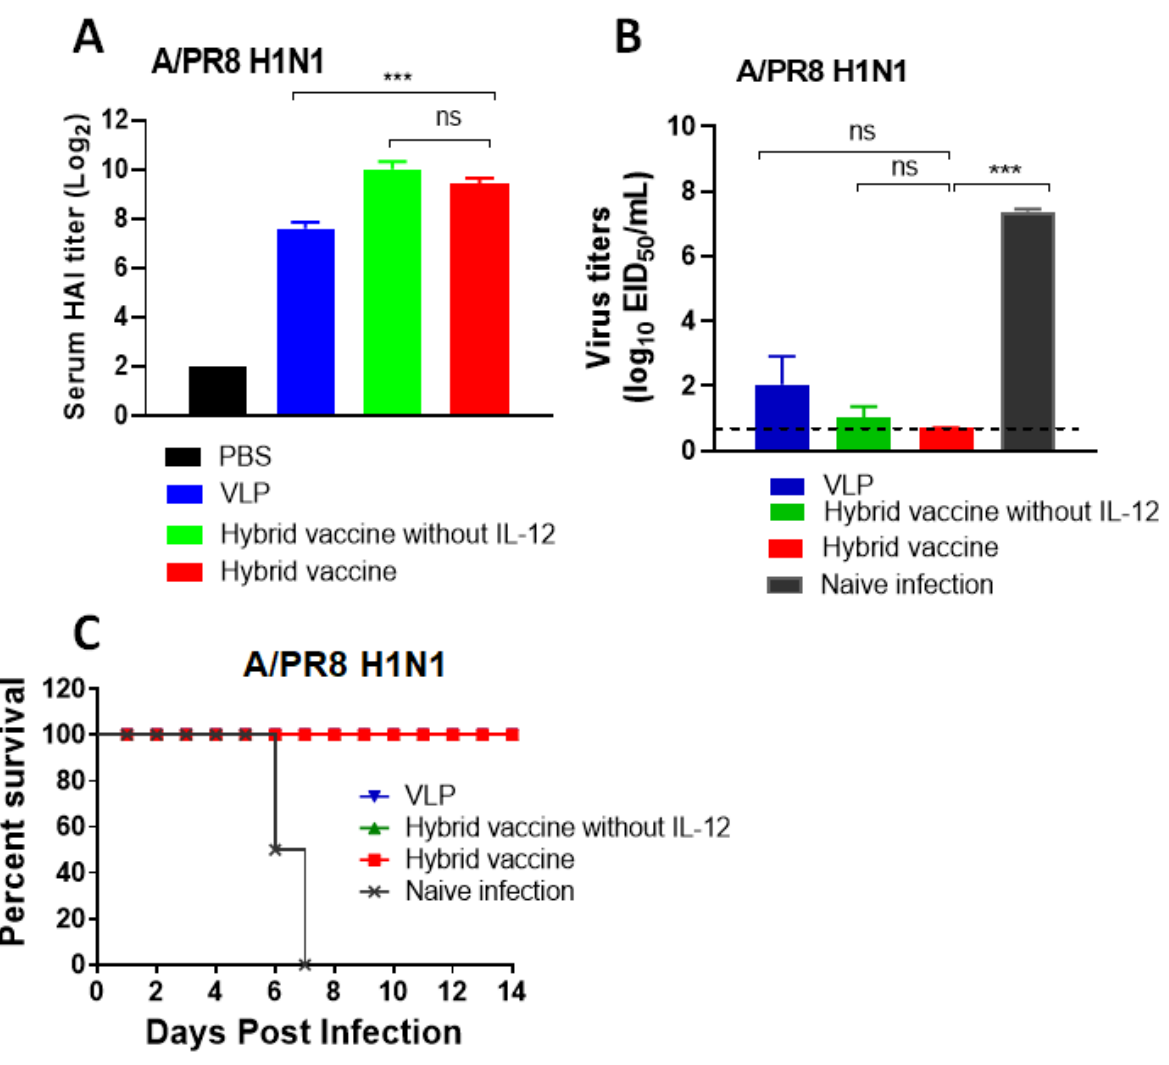
Figure 6. Hybrid vaccine protects against influenza A virus challenge. BALB/c mice were admin- istered with a hybrid vaccine (10 µ g/dose) or a hybrid vaccine without GPI-IL-12, as described in Figure 5. A booster dose was given after 33 days of the first dose. ( A ) HAI titer in the blood 2 weeks after the booster dose (day 48). Lung viral titer ( B ) and survival ( C ) of mice challenged with influenza A/PR8 H1N1 virus 3 months after the booster dose. The inoculation dose was 10 times LD 50 . ( C ) All three groups (VLP, hybrid vaccine and hybrid vaccine without IL-12) survived from PR8 challenge; therefore, the lines are superimposed, and only the red symbol is visible. Hybrid vaccine: VLP incor- porated with GPI-RBD-GM-CSF and GPI-IL-12. Statistical significance was calculated by one-way ANOVA and Dunnett’s post-multiple comparison tests. Error bars indicate the mean ± standard errors of the mean (SEM). ***; p < 0.001, ns; not significant.